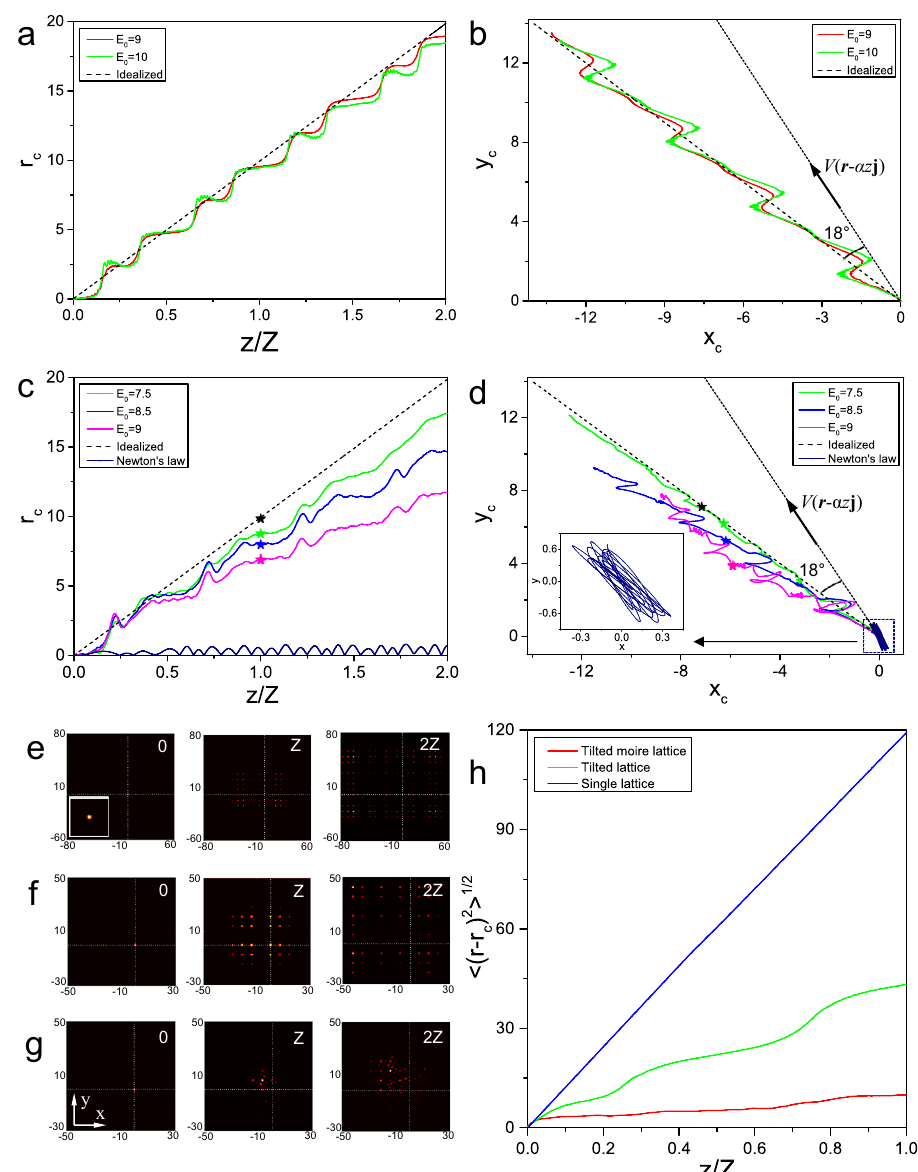
Fig. 2 | Numerical simulation of Thouless pumping in tilted moiré lattices. Pythagorean angle θ = arctan ð 4 = 3 Þ ( m =2, n =1) and tilt angles α =0.002 ( a , b , e ) and α =0.015 ( c , d , f , g ). a , c Displacements of the light beam COM, ∣ r c ∣ ,